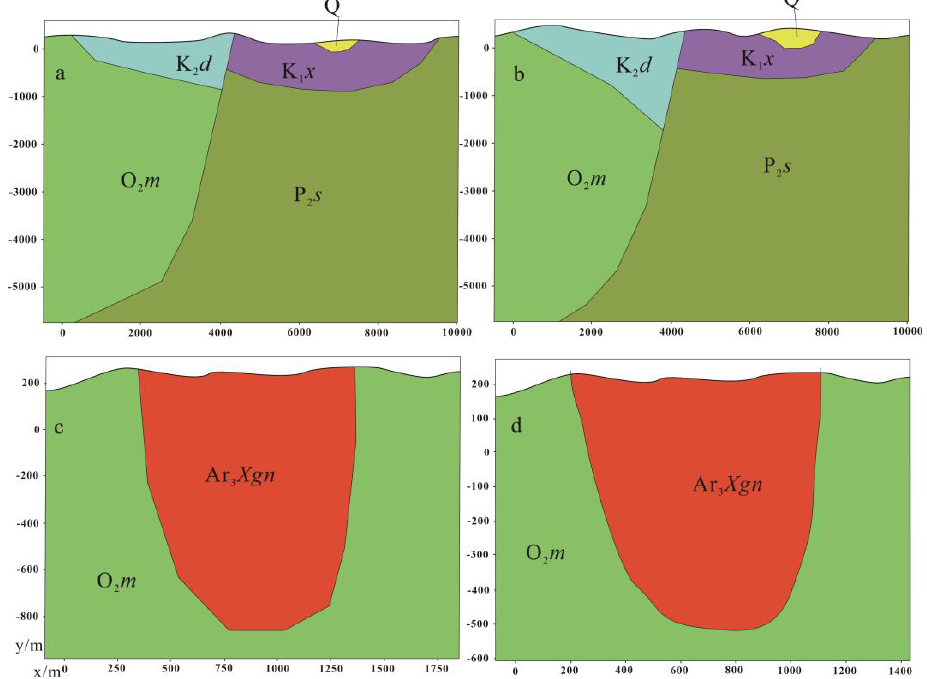
Figure 9. Comparison between the label and the generated section polyline in our work. ( a ) Label of complex stratum; ( b ) generated section polyline of complex stratum; ( c ) label of rock mass; ( d ) generated section polyline of rock mass.